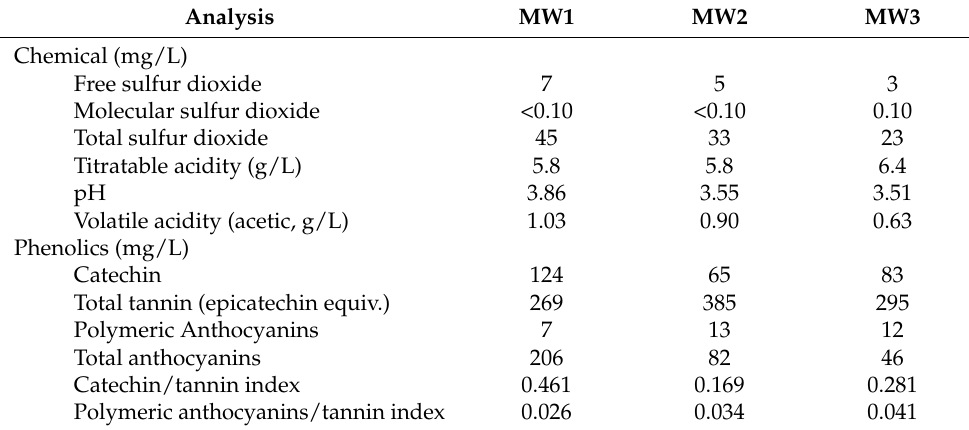
Table 4. Basic wine chemical and phenolic analysis of the model